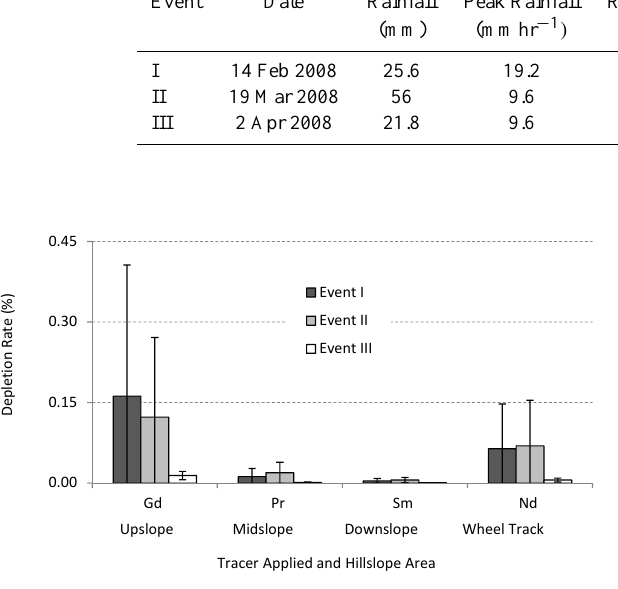
Fig. 3. Estimated erosion rates for hillslope areas tagged with rare earth oxides in three events at Loddington. Values are averages for four hillslope lengths, error bars are standard